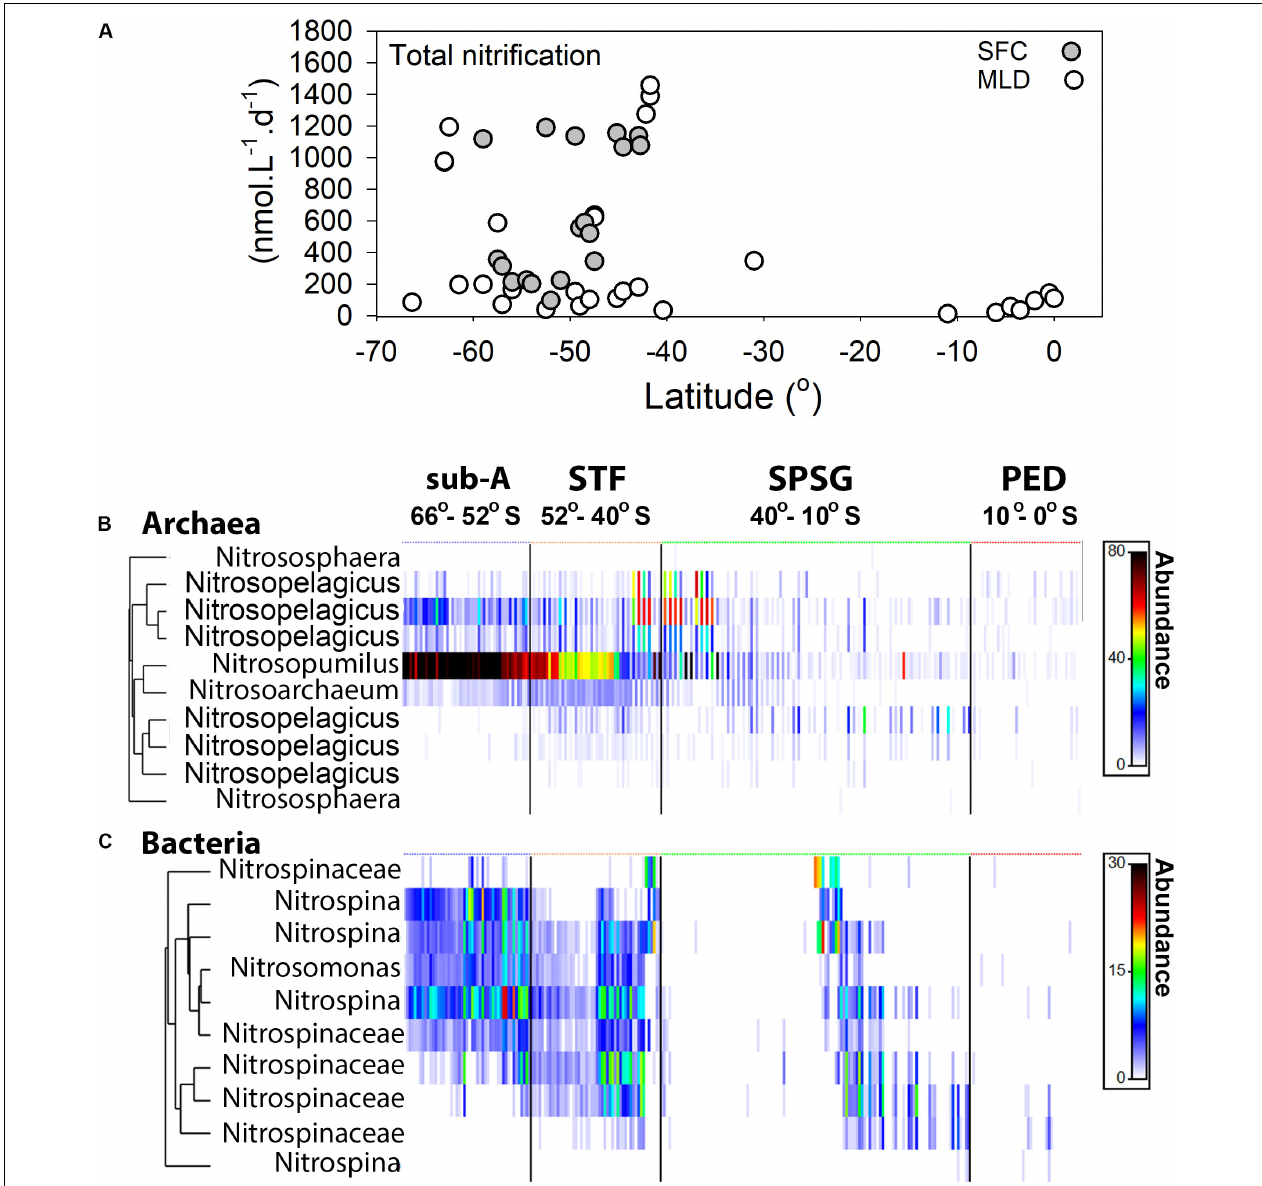
FIGURE 6 | Total nitrification rates in nmol L − 1 d − 1 in the South Pacific Ocean (A) . Filled gray circles are surface samples (SFC; 6 m), open circles are from the base of the mixed layer depth (MLD). Panel (B) shows a heat map of the archaeal nitrifying community and (C) a heat map of the bacterial nitrifying community. Most abundant OTUs are displayed and OTU sequence reads for both archaea and bacteria are square root transformed. Color bar shows the square root transformed sequence abundances. Dendrogram is not a phylogentic tree, but illustrates the clustering of strongly correlated OTUs. Blue, orange, green and red symbols above the heatmaps denote CTD stations in their respecitive oceanographic provinces; the sub-Antarctic; the STF; the SPSG and the PED. Due to detection limit of the denitrifier method we were unable to measure rates when environmental NO 3 − concentrations were < 1 µ mol L − 1 . Note, the Nitrospinaceae in the dendrogram refer to Nitrospinaceae that were not conclusively linked to the Nitrospina genus because of a relatively low sequence similarity.